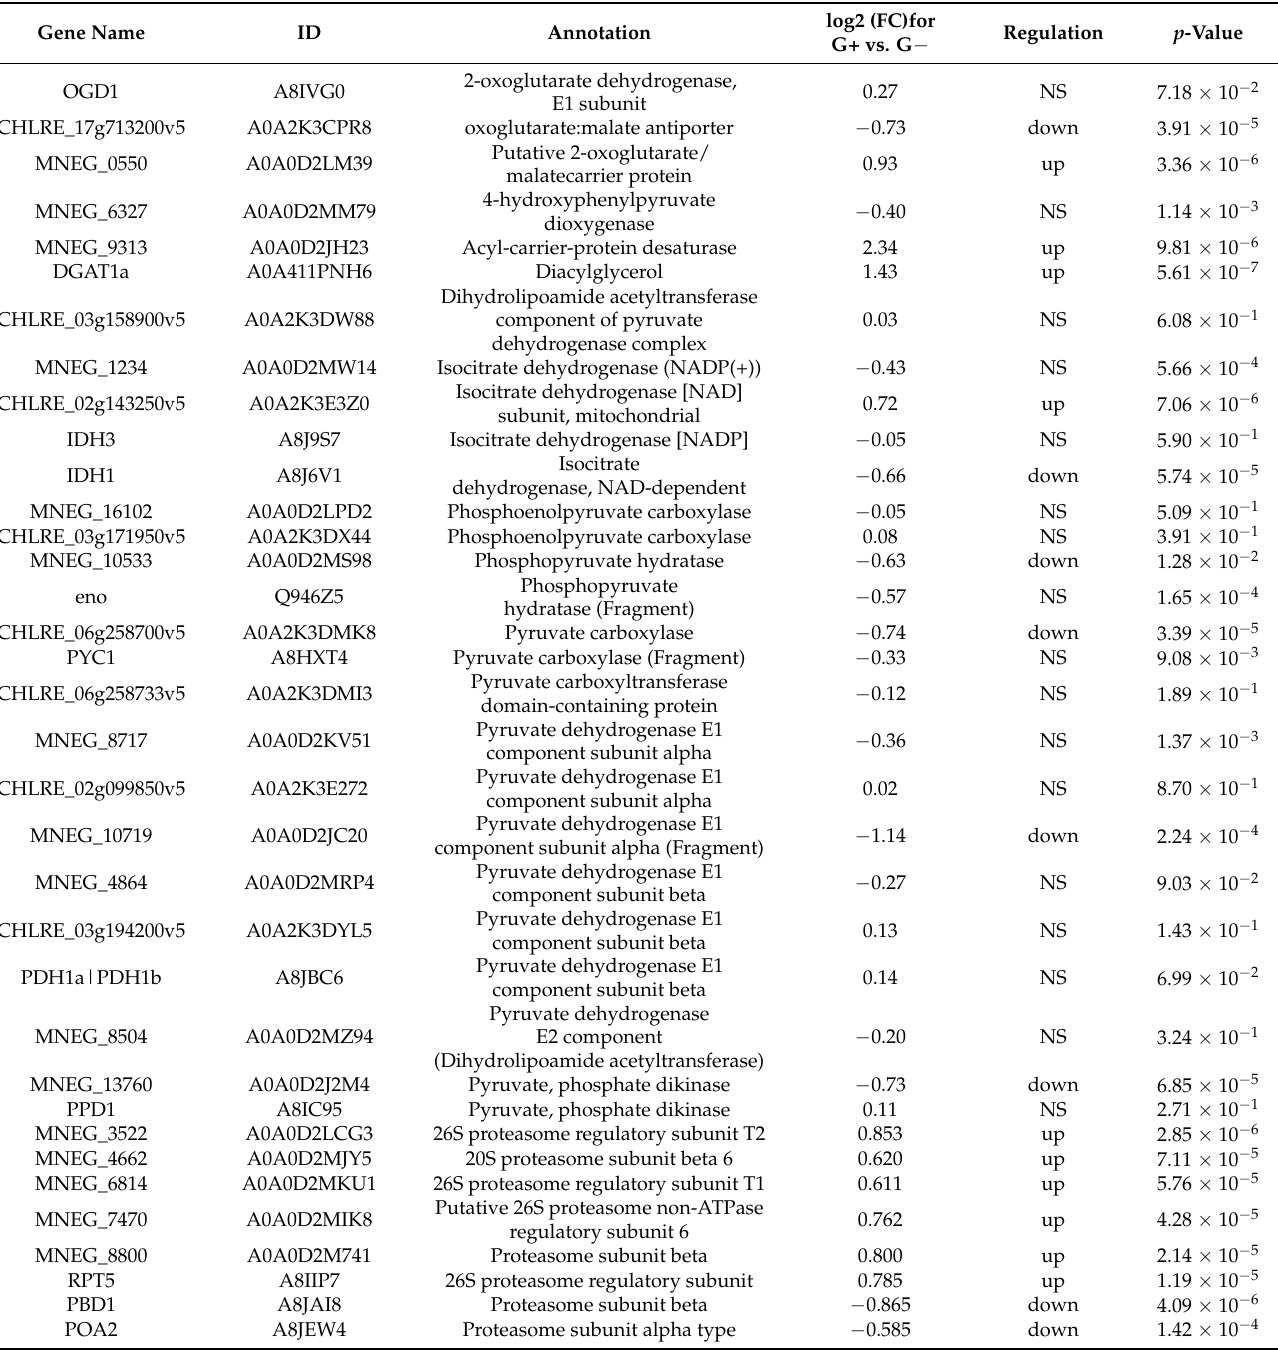
Table 1. Differentially expressed proteins related to carbohydrate metabolism and growth of Chromochloris zofingiensis with or without glucose